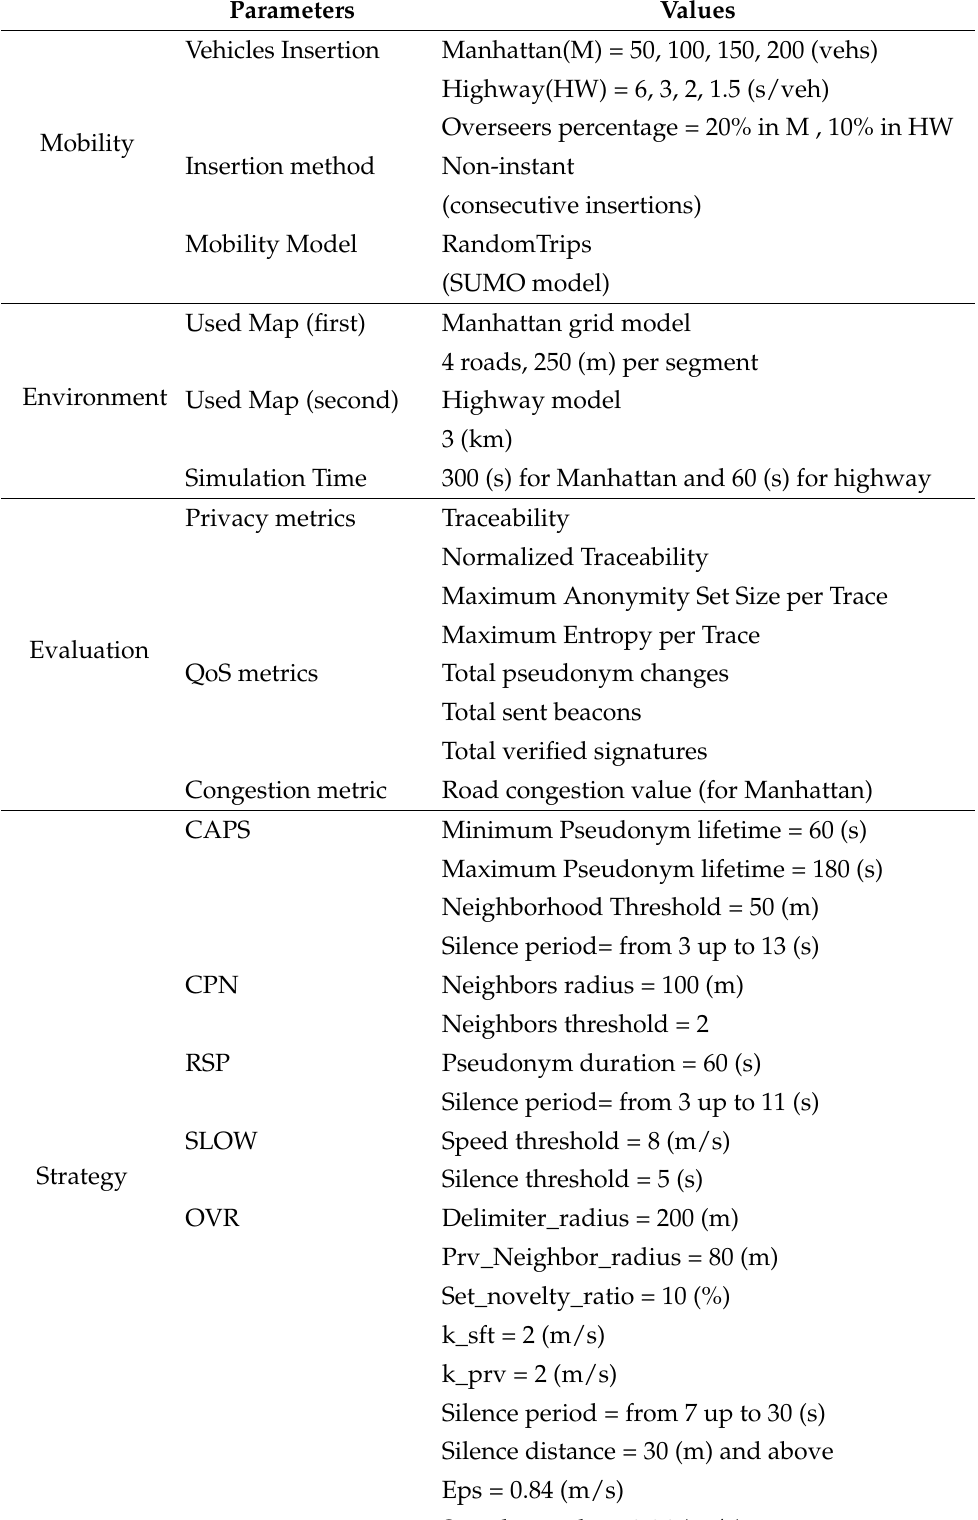
Table 4. Simulation parameters and